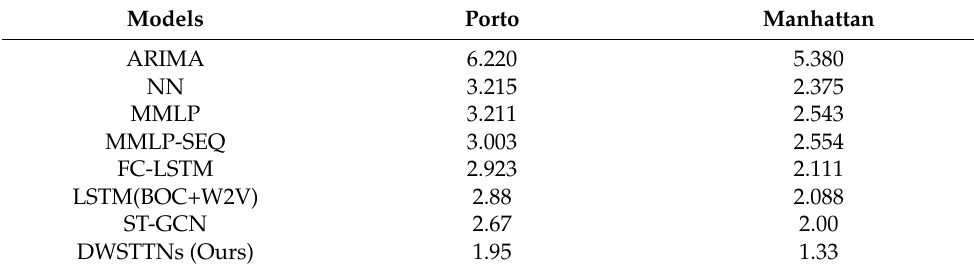
Table 1. The error distance score of all state-of-the-art baseline models on Porto and Manhattan datasets. The trajectory was only the pick-up and drop-off